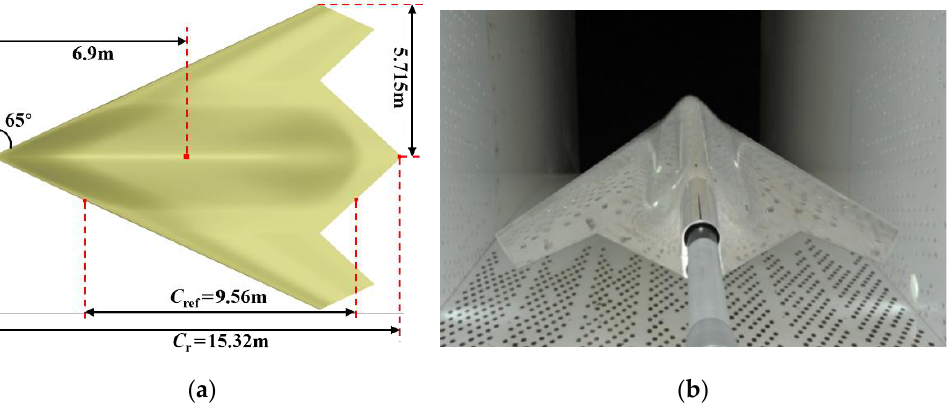
Figure 1. Basic geometric parameters of the model. ( a ) Original model configuration; ( b ) image of scaled model in the wind tunnel.